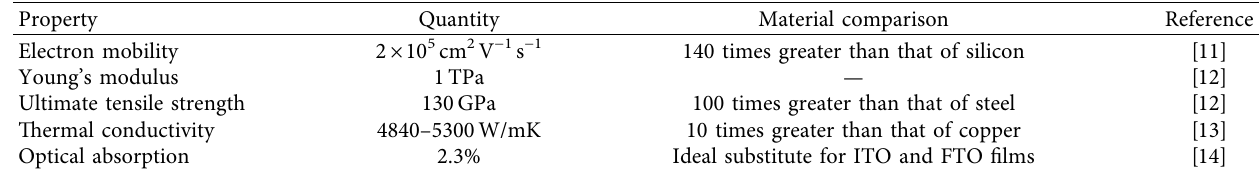
Table 1: Properties of